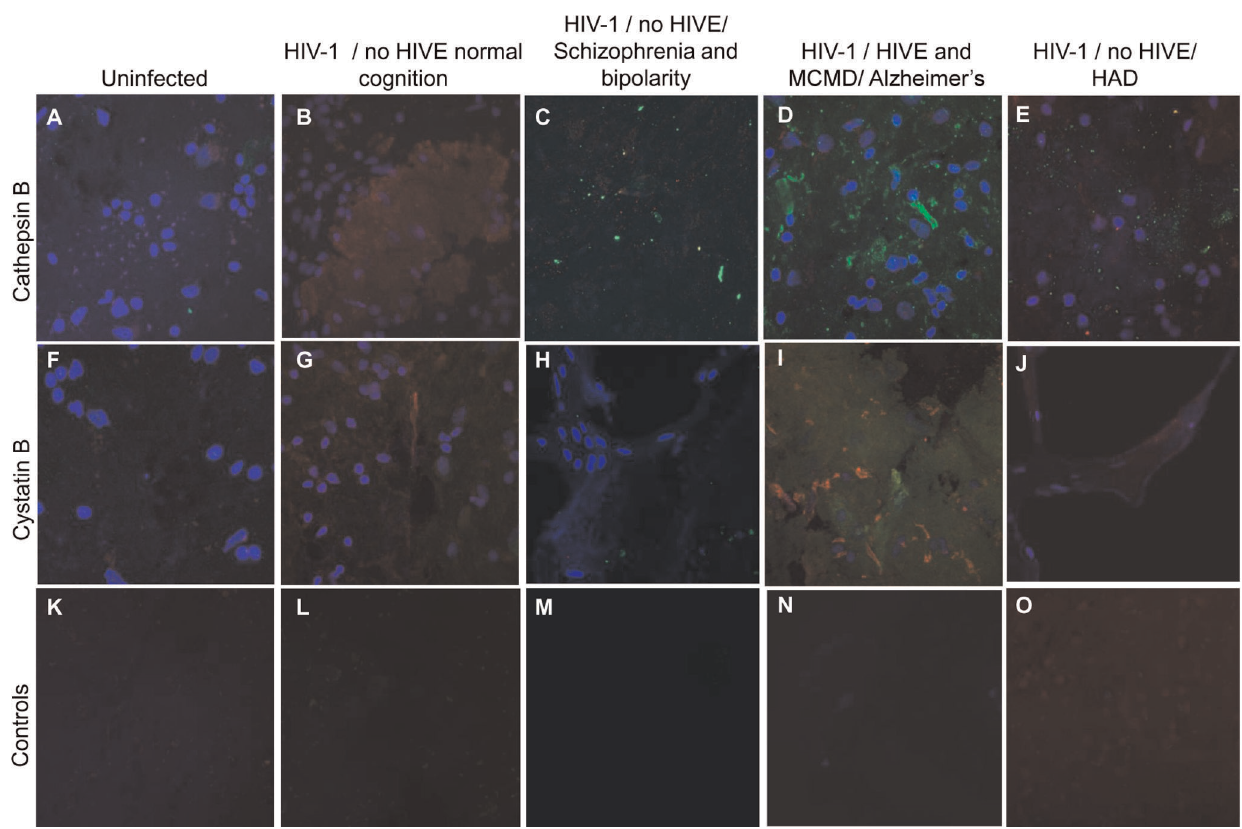
Figure 9. Expression of cathepsin B and cystatin B in the basal ganglia of post-mortem brain tissues. Basal ganglia tissue from HIV- seronegative (A, F and K) and HIV seropositive (B-E, G-J and L-O) patients were stained with mouse anti-human cathepsin B followed by Alexa 488 conjugate goat anti-mouse (green), or mouse anti-human cystatin B followed by Alexa 488 conjugate goat anti-mouse (green), and rabbit anti- human Iba-1 followed by Alexa 546 goat anti-rabbit (red), and nuclear staining by DAPI (blue). Unstained tissues were used as controls as illustrated in K to O. Magnification: 63 6 .